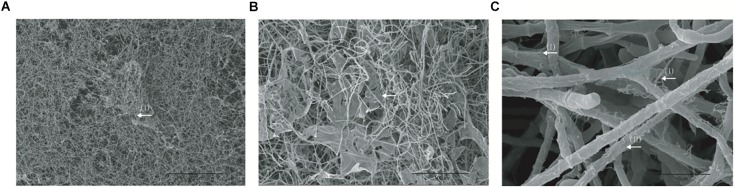
SEM images of the biofilms of T. mentagrophytes SEM provided three-dimensional images for biofilm structural assessment, with low magnification of x100 displayed in (A) and high magnifications of x500 and x5000 displayed in (B) and (C), respectively. Two types of peculiar ECM architecture can be observed: (I) an extremely thin “blanket-like” layer covering the areas between hyphae (B); (II) very fine “mesh-like” layer wrapping the filaments of hyphae (C).